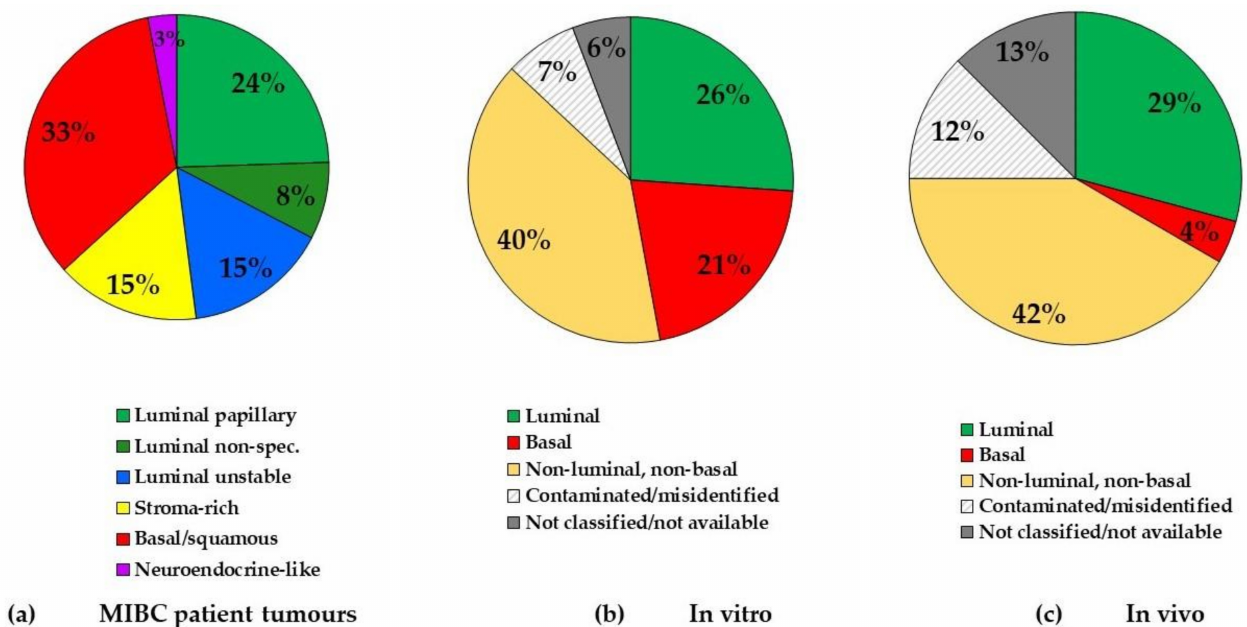
Figure 1. Comparison of muscle-invasive bladder cancer (MIBC) subtype frequency in patient tumours and human bladder cancer (BCa) cell lines used in radiotherapy (RT) experimental studies in vitro and preclinical studies in vivo. ( a ) MIBC tumour subtypes (classified by [36]); ( b ) cell line subtypes used in experimental studies of RT in BCa in vitro (classified by [46]); ( c ) cell line subtypes used in preclinical studies of radiotherapy in BCa in vivo (mice xenografts) (classified by